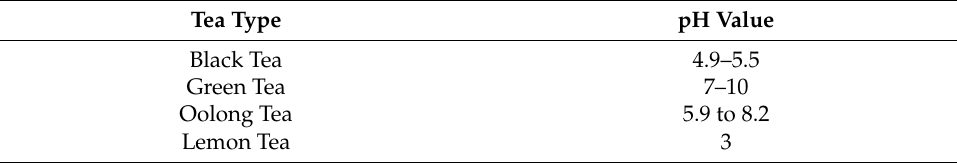
Table 1. General pH values for main tea samples.